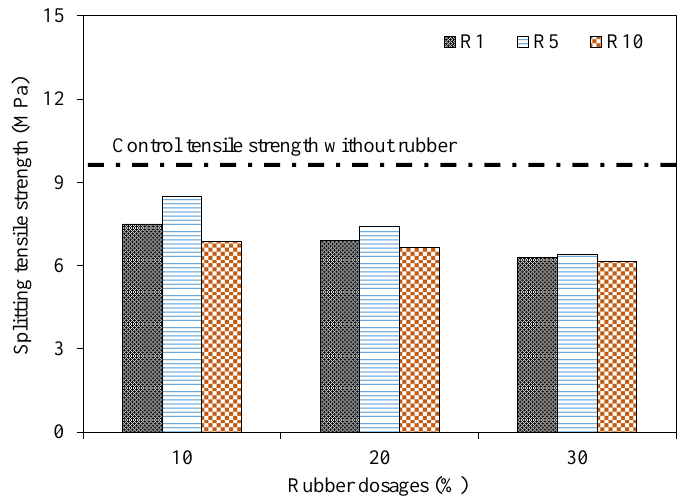
Figure 11. Splitting tensile strength for the mixture incorporating various dosages of rubber at 28 days.